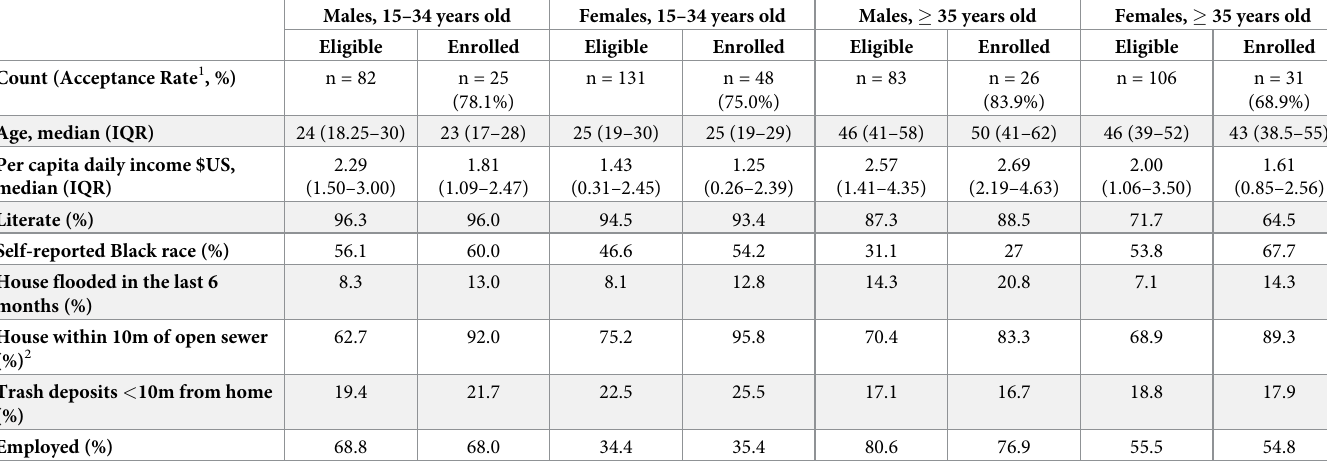
Table 1. Characteristics of the source urban slum population (“eligible”) and study participants (“enrolled”), by age and gender